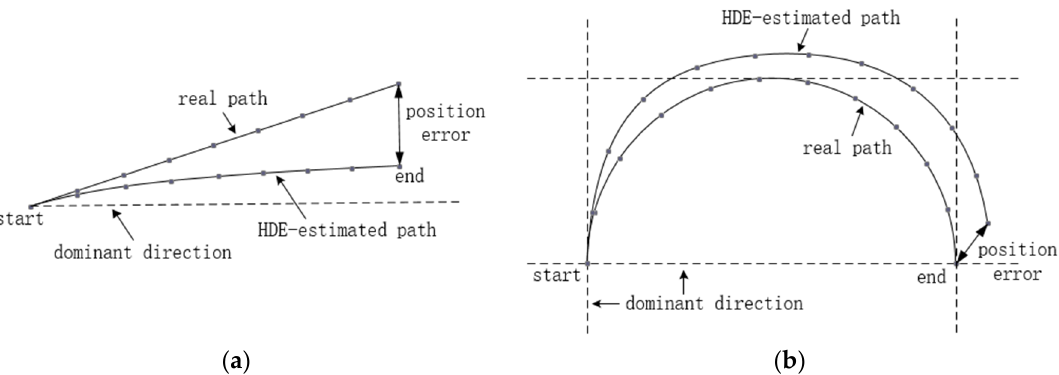
Figure 2. The calculated generalized likelihood ratio (GLRT) at some sampling moments.